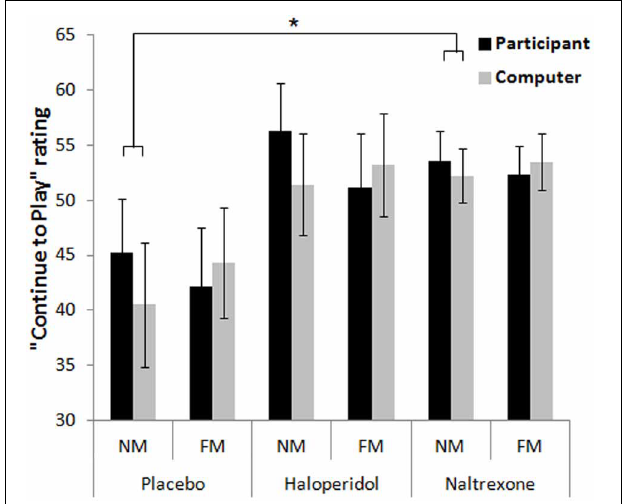
FIGURE 4 | Motivational ratings on the slot machine task showed an outcome (near-miss, full-miss) by control (participant-chosen, computer-chosen) interaction, whereby participant-chosen near-misses increased motivation to continue relative to the computer-chosen near-misses, in the placebo group (and haloperidol group), and this was attenuated in the naltrexone group. Error bars indicate standard error of the mean. ∗ p < 0 .